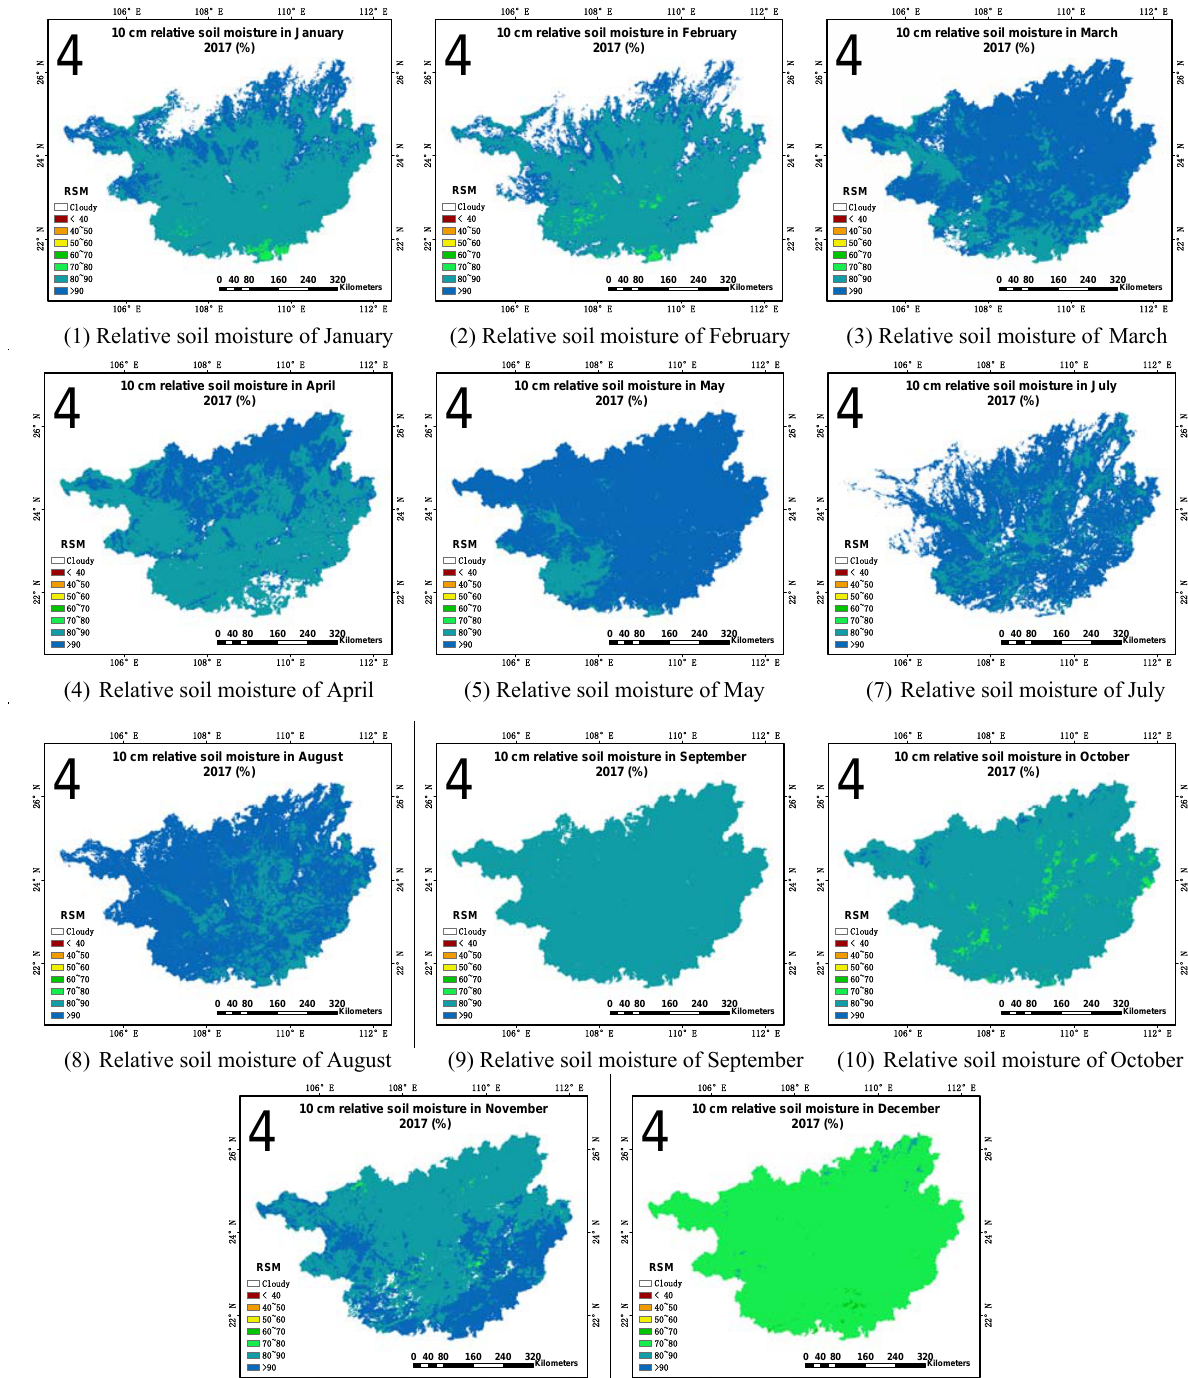
Figure 2. Relative soil moisture in Guangxi from January to December in 2017 (from left to right, from top to bottom)